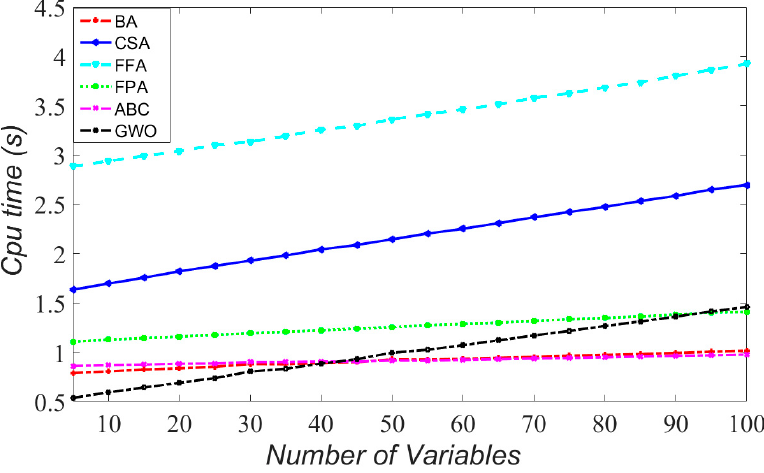
Figure 6. Impact of increasing number of function dimensions vs. CPU time for Sphere function.